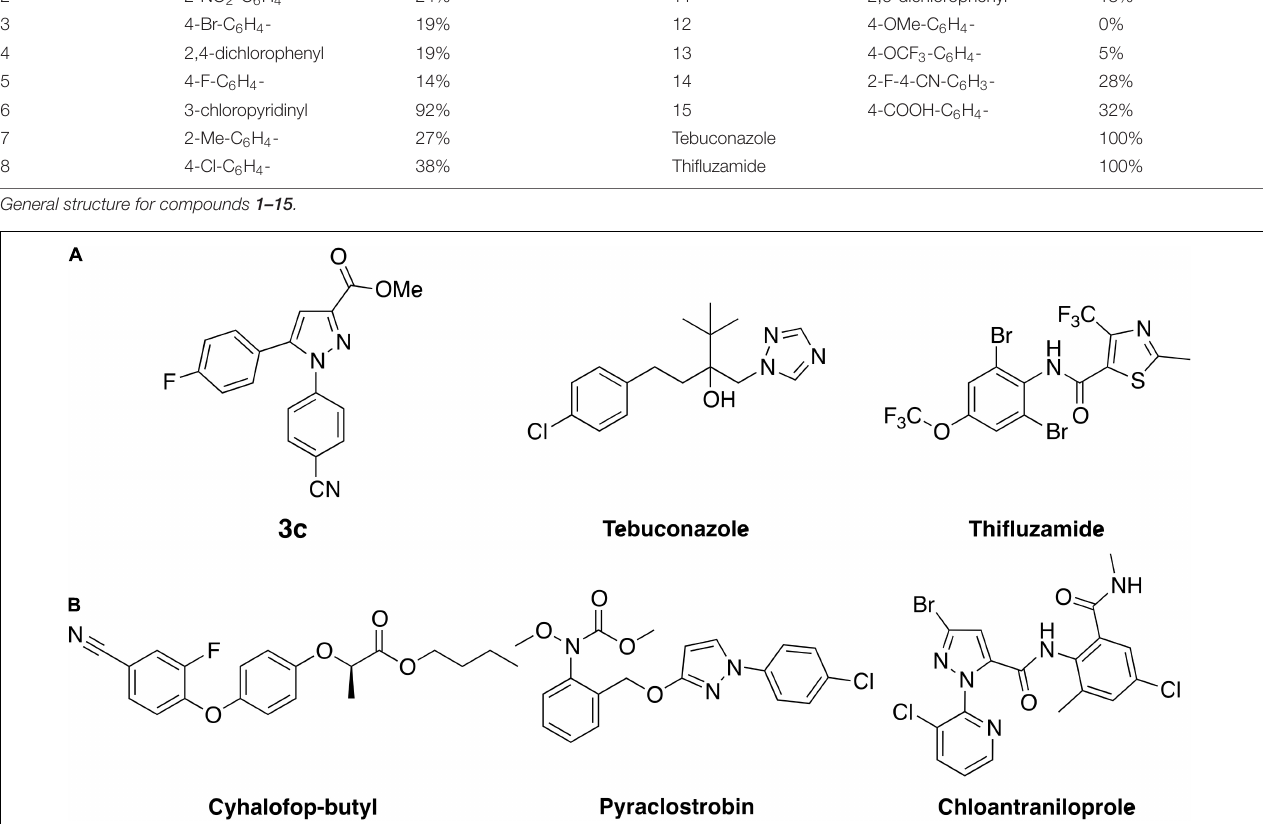
FIGURE 2 | (A) Structure of lead compound 3c and fungicide controls tebuconazole as well as thifluzamide. (B) Commercial pesticides whose synthetic materials were used to derive compound 3c .